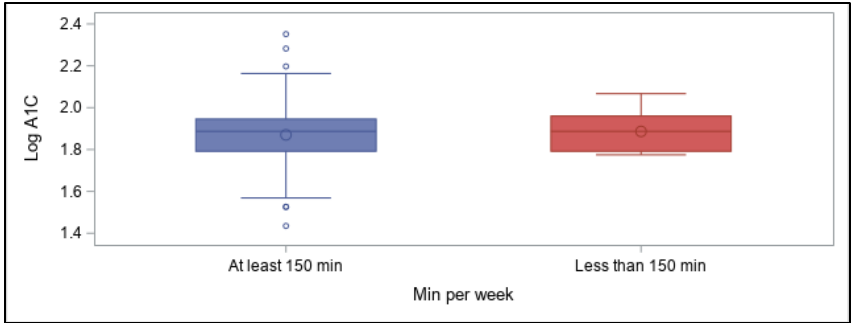
Figure 3. Total physical activity time by recommended amount and association with log A1C values. The number of days of activity per week ranged from 2 to 7 (Figure 4), demonstrating that all participants were physically active. However, frequency of physical activity was not a significant predictor of